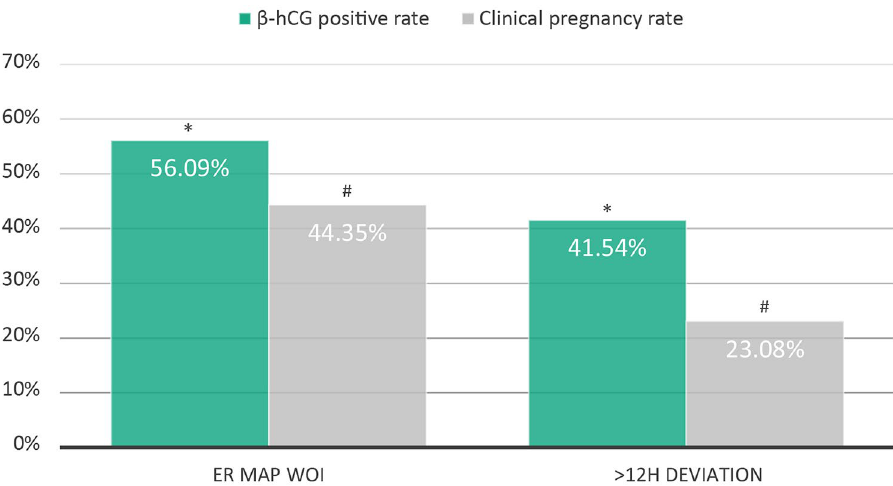
Figure 2. Reproductive outcomes of patients after the first single embryo transfer following ER Map test. Positive B-hCG rates (green bars) and clinical pregnancy rates (grey bars) comparison between the group of patients that followed ER Map progesterone pretreatment and those that deviated more than 12h from this recommendation. X 2 test, *p = 0.02, # p < 0.001 n = 746 sET (ER Map WOI N = 681, > 12h deviation n =